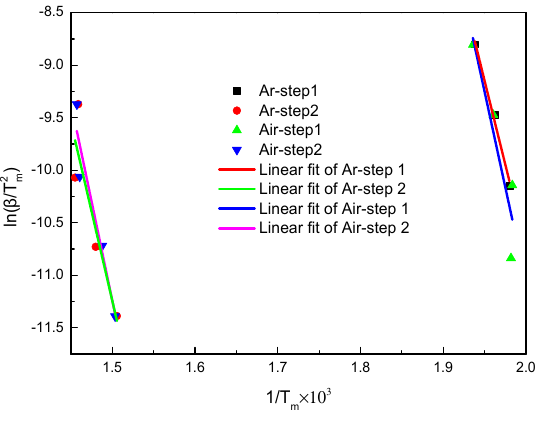
Air-step1 Air-step2 Linear fit of Ar-step 1 Linear fit of Ar-step 2 Linear fit of Air-step 1 Linear fit of Air-step 2 l n